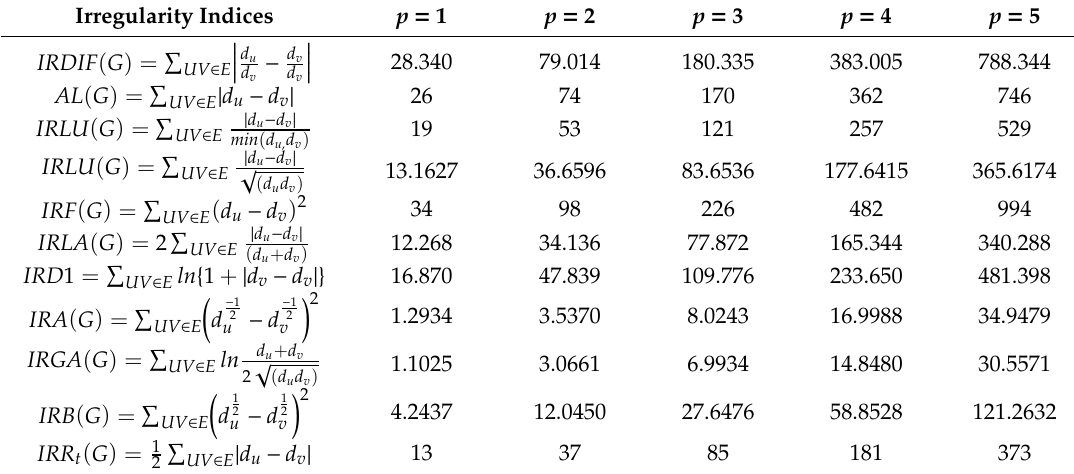
Table 2. Irregularity indices for NS 1 [ p ] polypropylenimine octaamin dendrimers. Irregularity